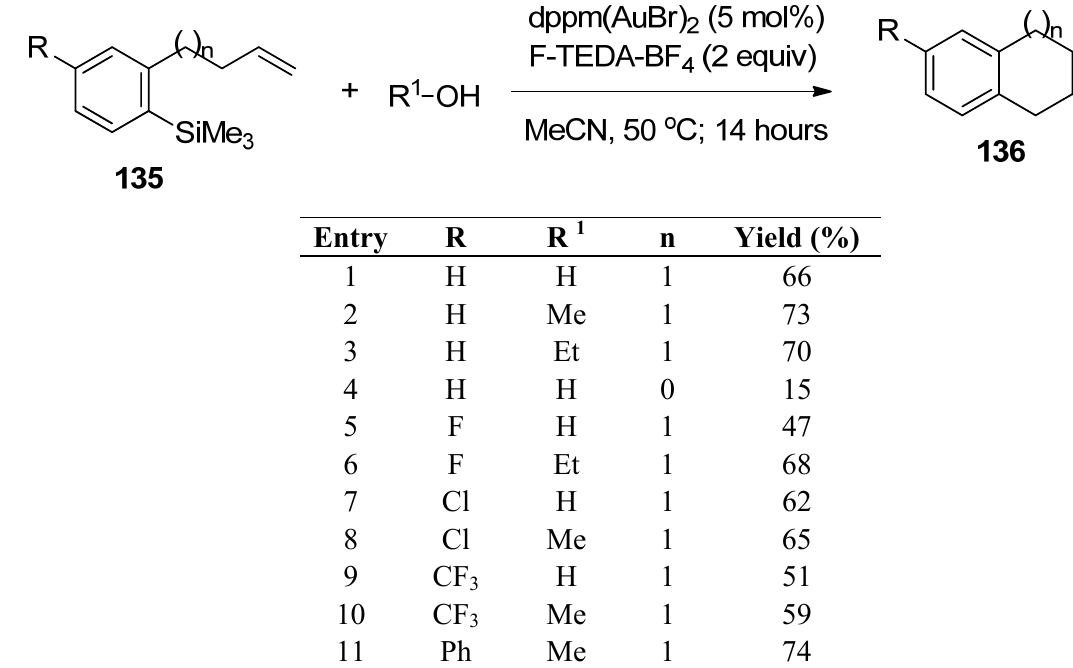
Table 13. Gold-catalyzed and F-TEDA-BF